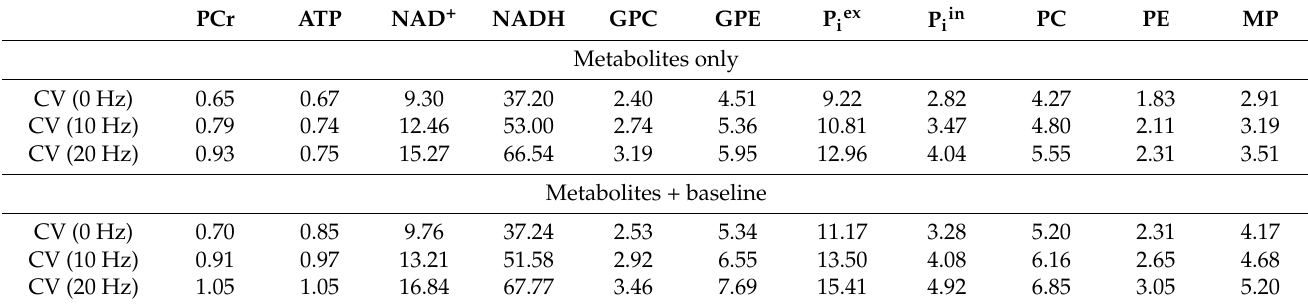
Table 1. Effect of line-broadening on coefficient of variation (CV) at 3 Tesla.